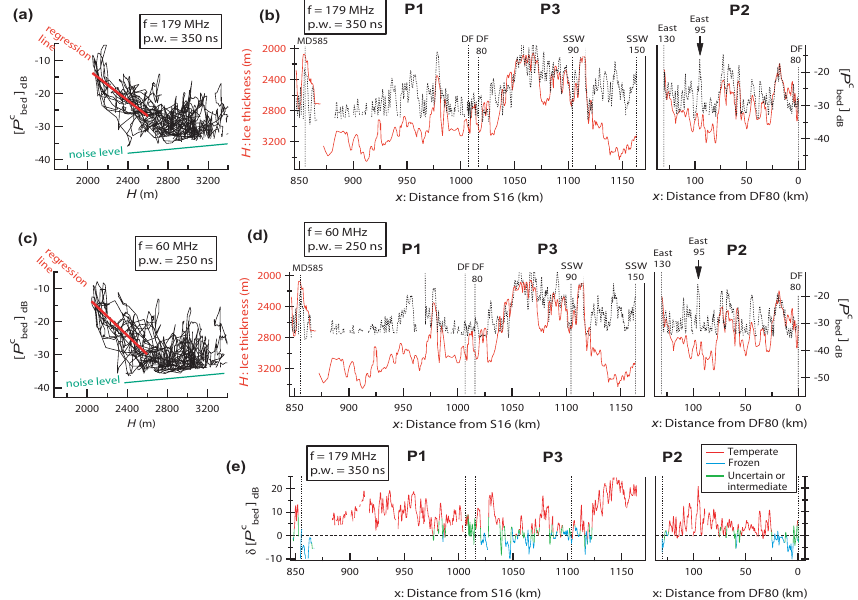
Fig. 3. Variation of the geometrically corrected return power from the bed [ P c ] dB (dB) in terms of ice thickness H (a) , (c) and location bed x (b) , (d) , along legs P1, P2, and P3 in the vicinity of Dome Fuji. The upper and middle rows show the data collected at radar frequencies of 60MHz and 179MHz, respectively. Ice thickness H is positive downward. “p.w.” is pulse width. See the text of Section 3 for details.